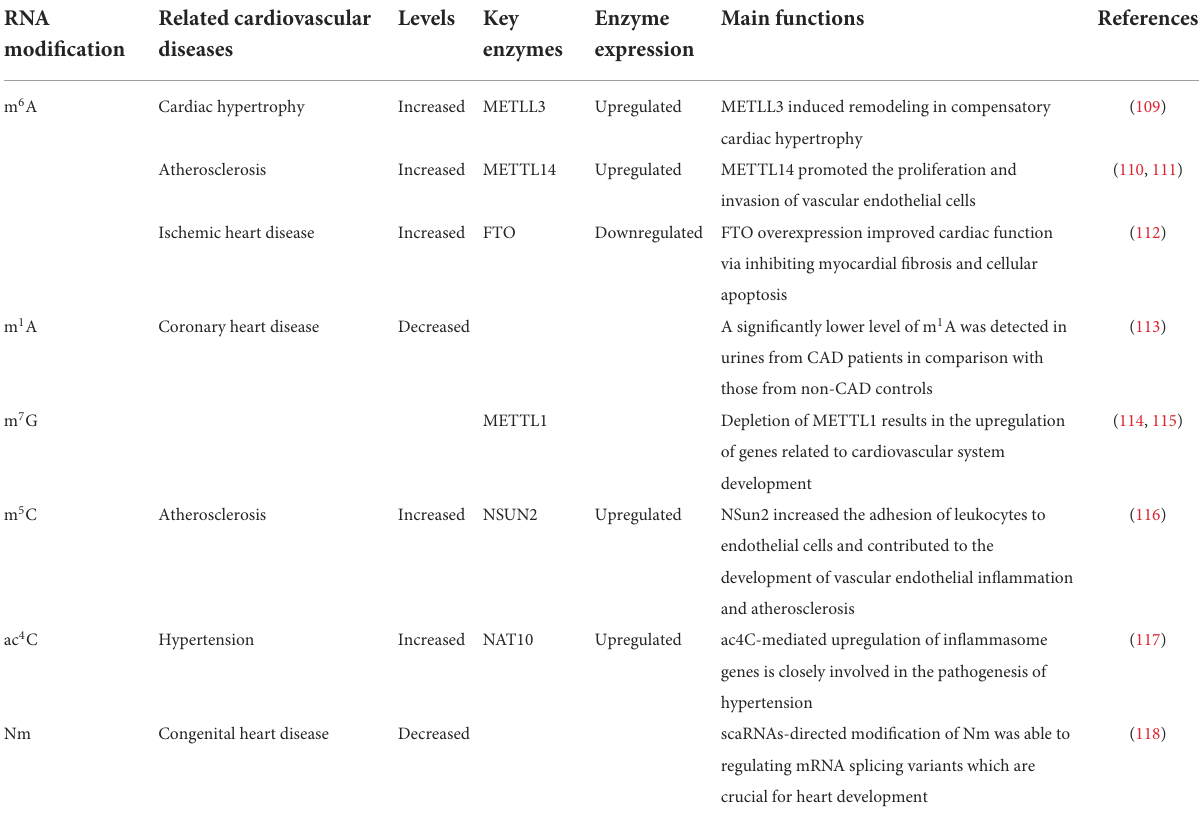
TABLE 1 The roles of RNA modifications in CVDs.